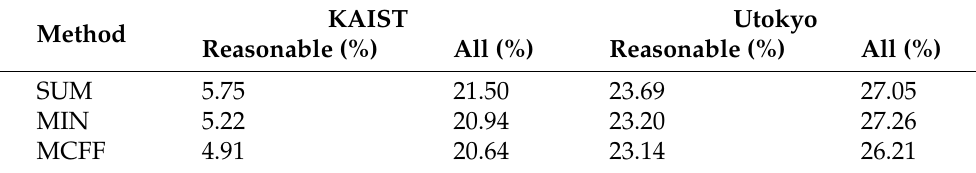
Table 2. Comparison of the different fusion methods on KAIST and